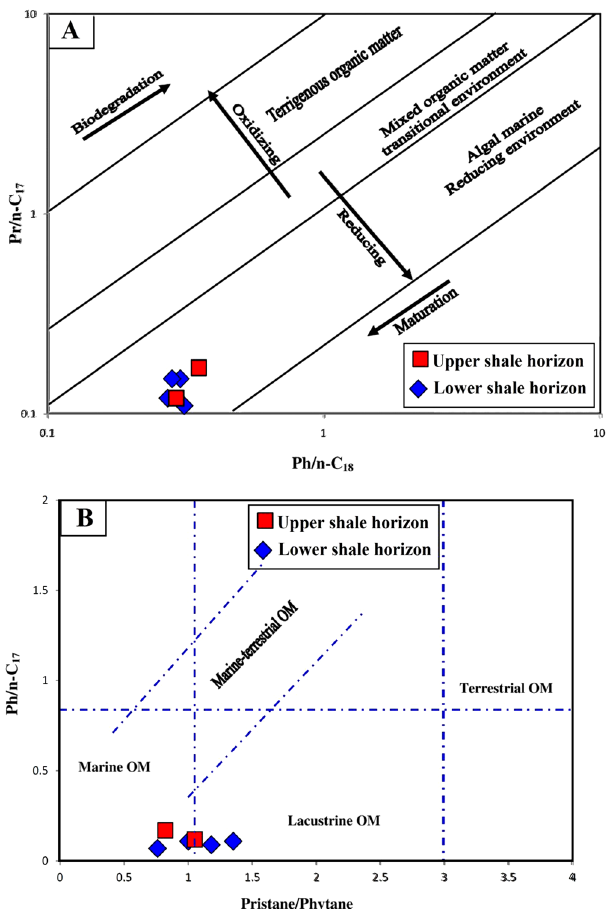
Figure 11. Biomarker cross-plots of isoprenoid ratios: Pr/Ph, Pr/C 17 , and Ph/C 18 , showing that the analyzed shale samples received a high contribution of algal organic matter and deposited in mainly marine origin and little connection to freshwater and preserved under reducing environmental